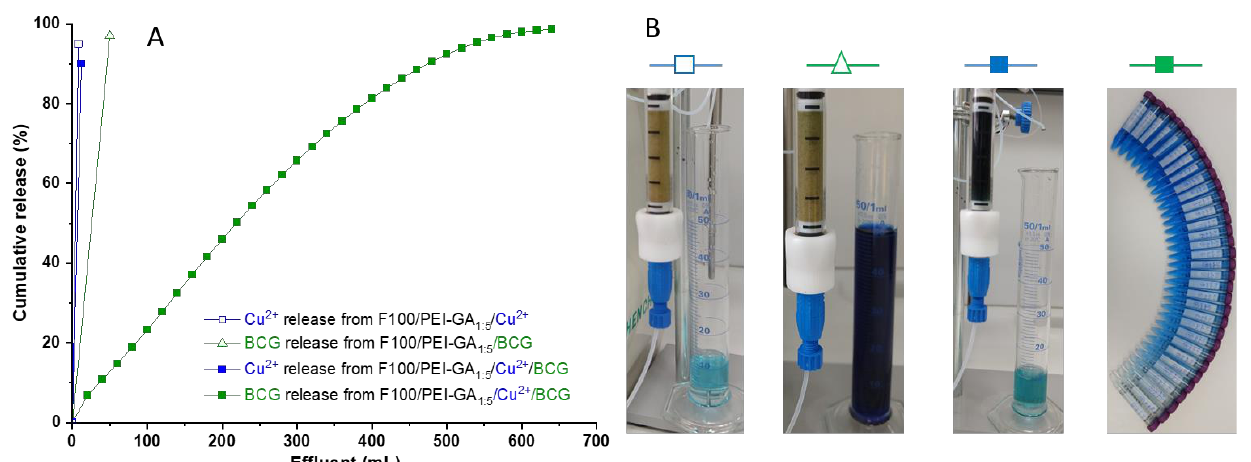
Figure 11. Desorption efficiency of Cu 2+ and BCG from F100/PEI-GA 1:5 loaded with single components (empty symbols) and bi-components (full symbols) ( A ) evaluated in dynamic conditions (2 mL/min) in a column ( B ).